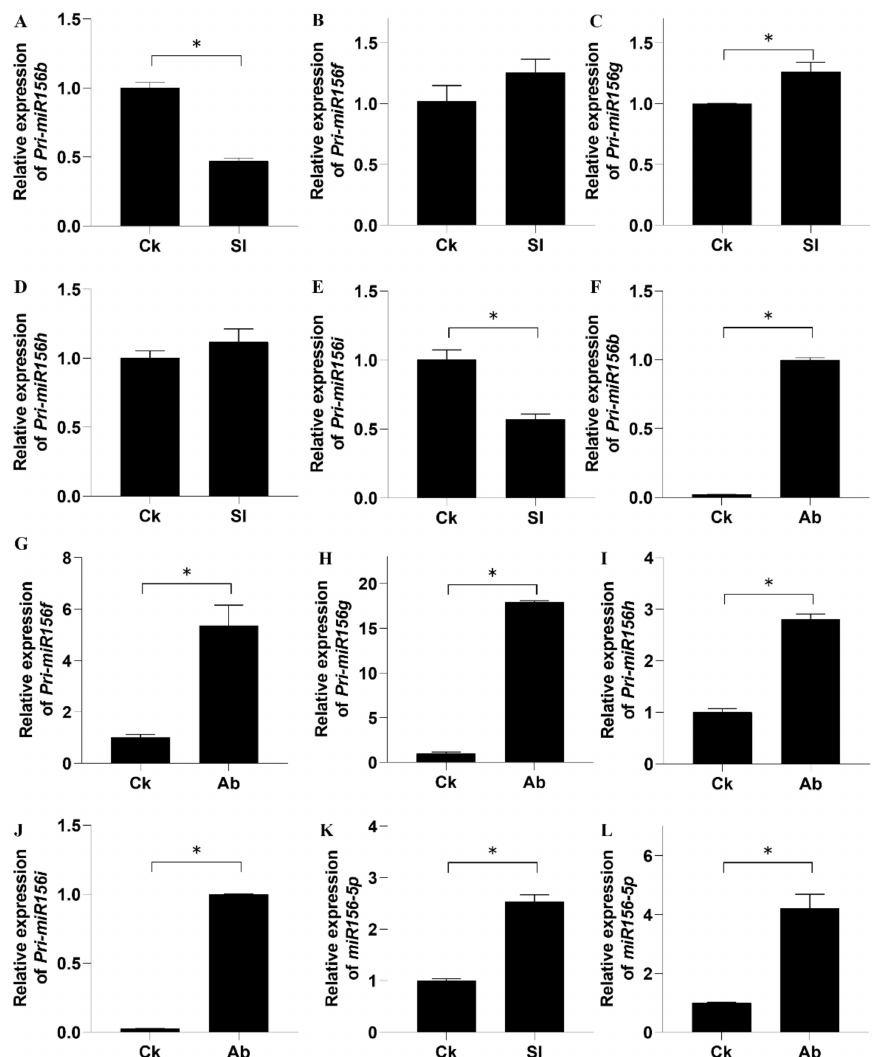
Figure 6. Relative expression levels of miR156s in lotus. The lotus were grown at full light (Ck) and 70% shade (Sl) treatment for 1 month and then leaves were sampled for RT-qPCR analysis of the miR156 family members’ precursors ( A – E ) and miR156-5p ( K ). Normal (Ck) and aborting (Ab) flower buds were collected from 1-month-old lotus for RT-qPCR analysis of the miR156 family members’ precursors ( F – J ) and miR156-5p ( L ). Values are the means ± SE of three independent experiments with at least three replicates for each. U6 small nuclear RNA was used as an endogenous control to normalize expression levels of miRNAs from RT-qPCR. Asterisks indicate that mean values are significantly different in comparison with Ck at p < 0.05 according to a t